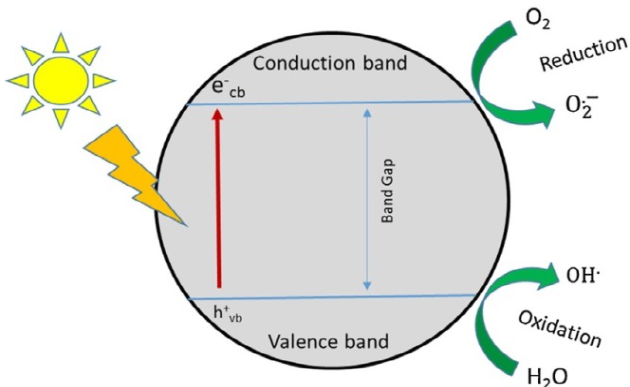
Fig. 1. Mechanism of Fig.1. Mechanism of Photocatalysis